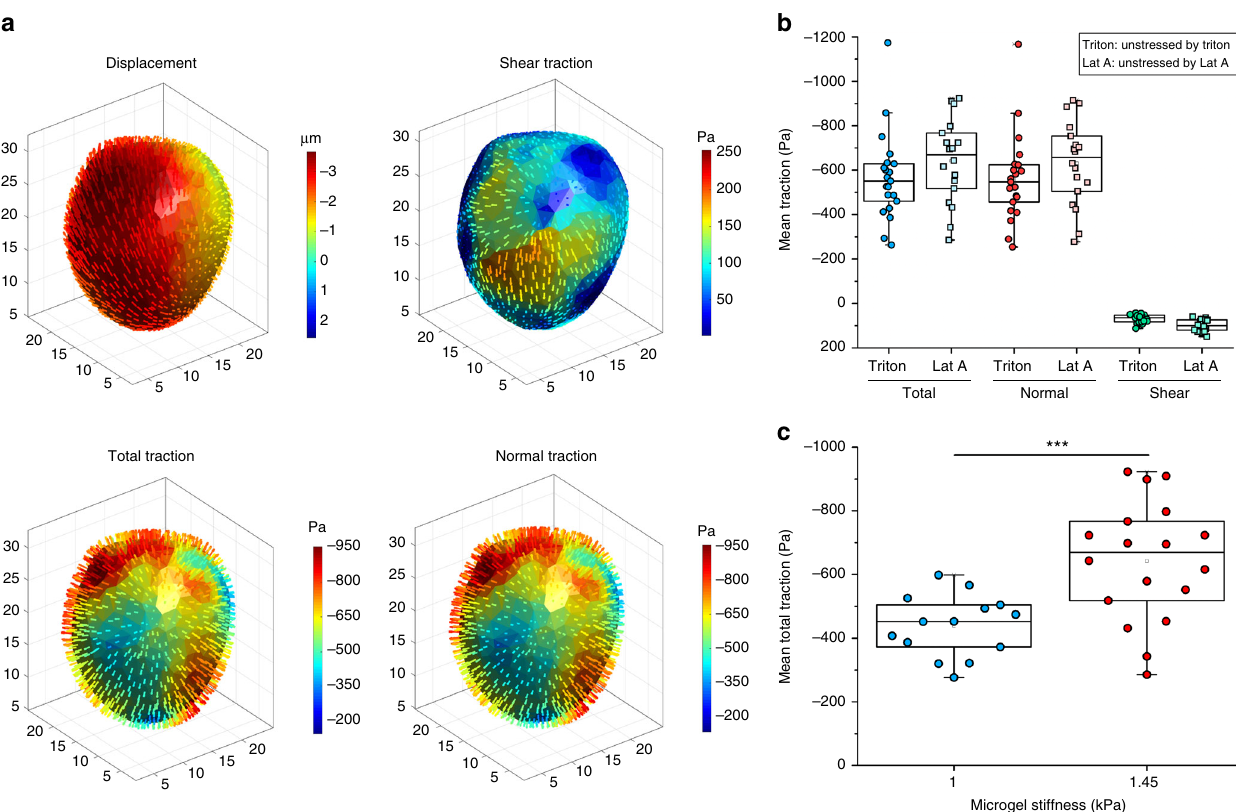
Fig. 5 Quanti fi cation of tractions generated by multilayered cells. a An example of deformation and tractions on the elastic round microgel (ERMG) exerted by the multilayered cells. b Summarized data of total, normal, and shear tractions applied onto the ERMGs (Young ’ s modulus of 1.45 kPa). n = 21 ERMGs for Triton-treated cells and n = 18 ERMGs for Lat A-treated cells. c Scatter plot of mean total traction with respect to Young ’ s modulus of the microgels. The tractions were calculated using 1 µ M Latrunculin A-treated samples as the unstressed reference condition. Solid lines in the box plots correspond to 25th percentile, median, and 75th percentile; n = 14 for 1 kPa; n = 18 for 1.45 kPa. *** P < 0.001. One-tailed Student ’ s t -test was